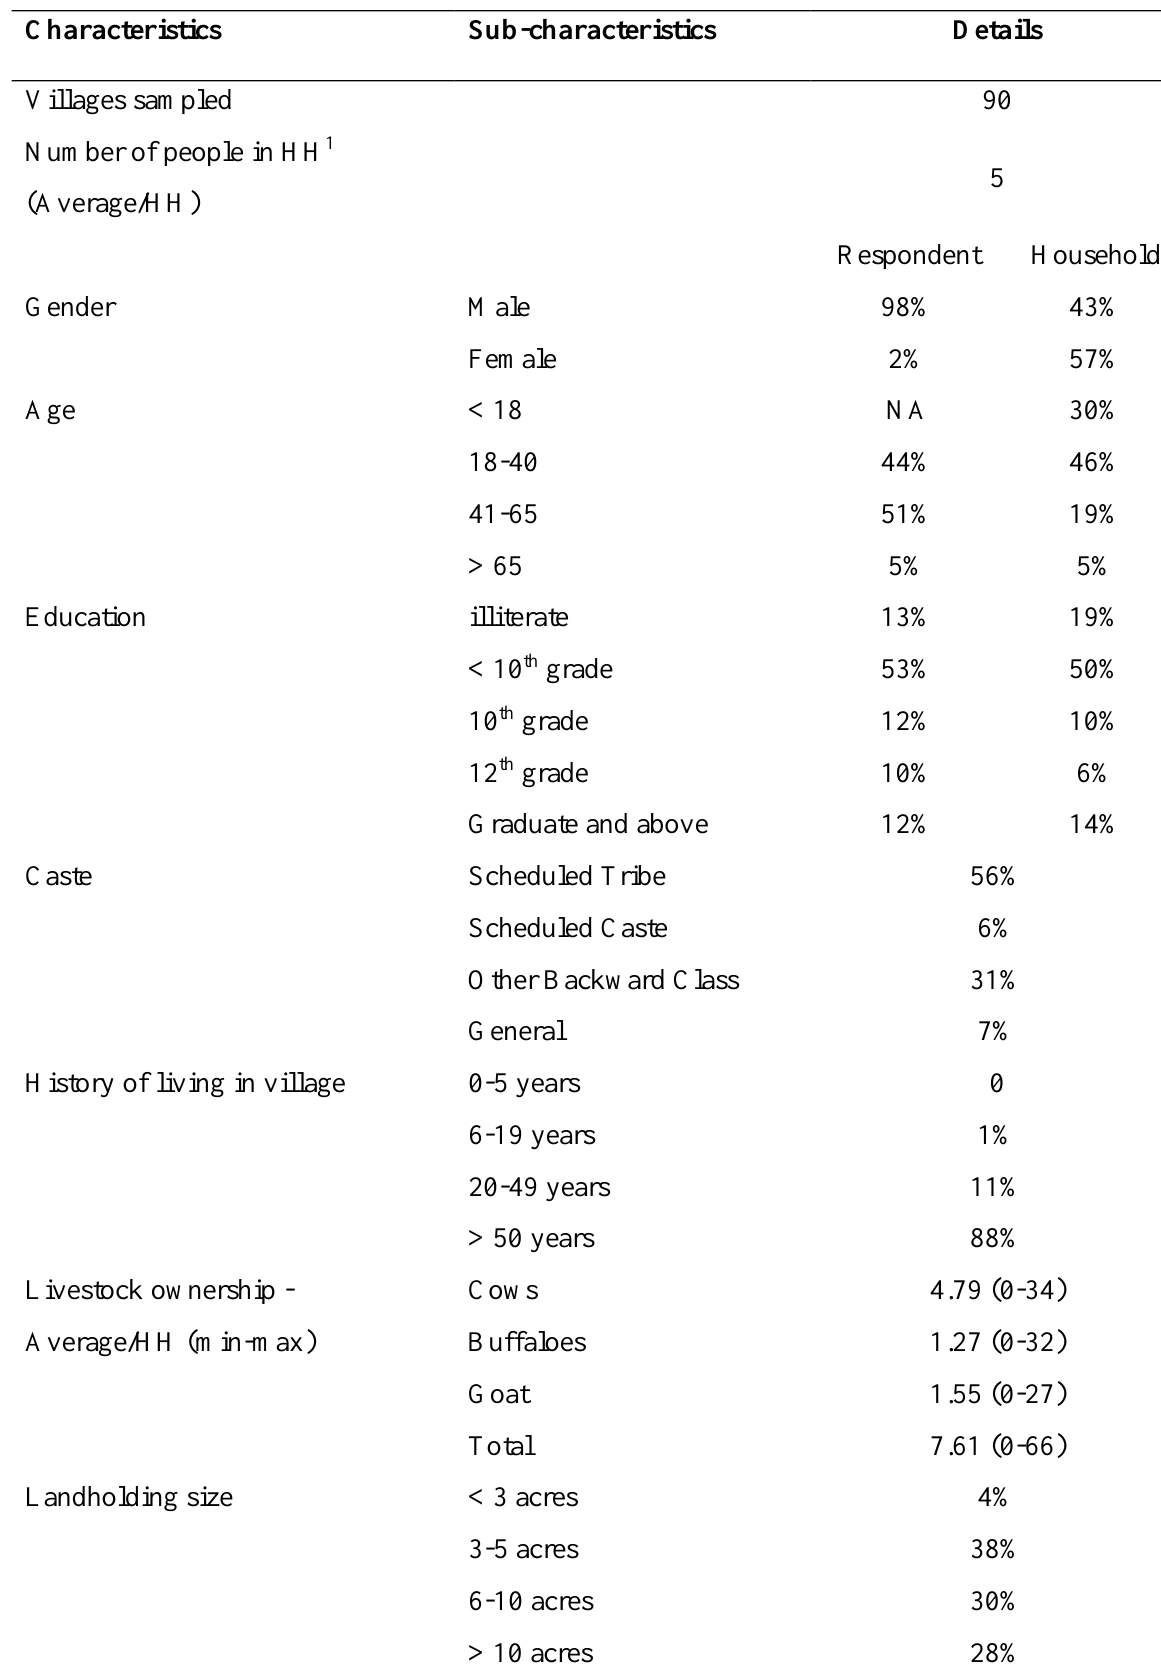
Table A1.2: Demographic and socio-economic characteristics of respondents (N =